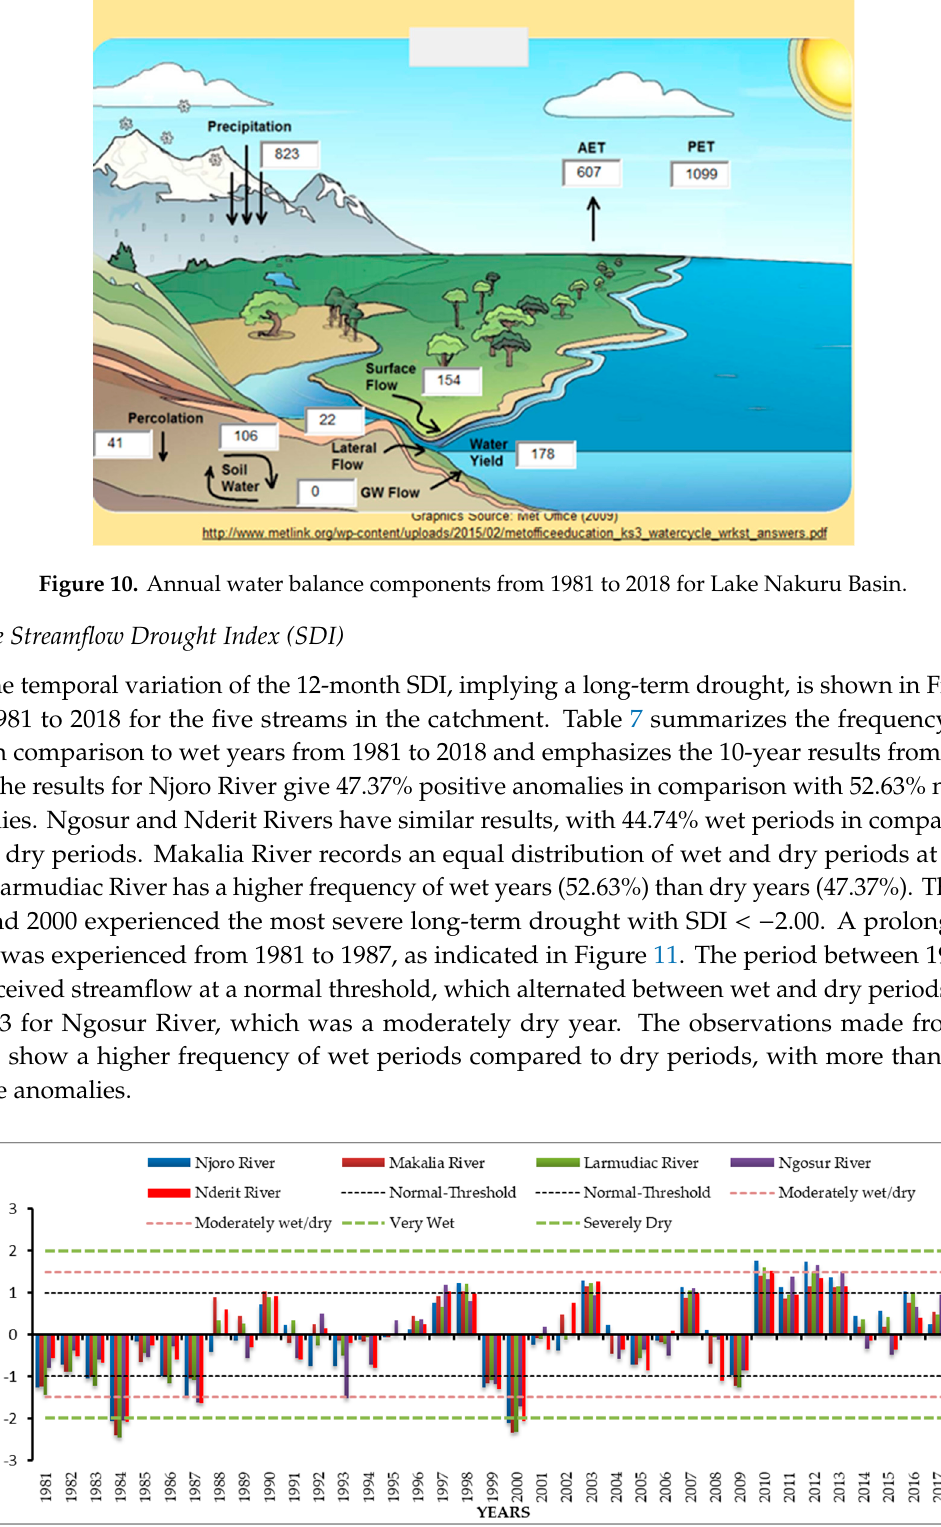
Figure 11. Annual (12–month) streamflow drought index (SDI) for streams in the Lake Nakuru subcatchment from 1981 to 2018.